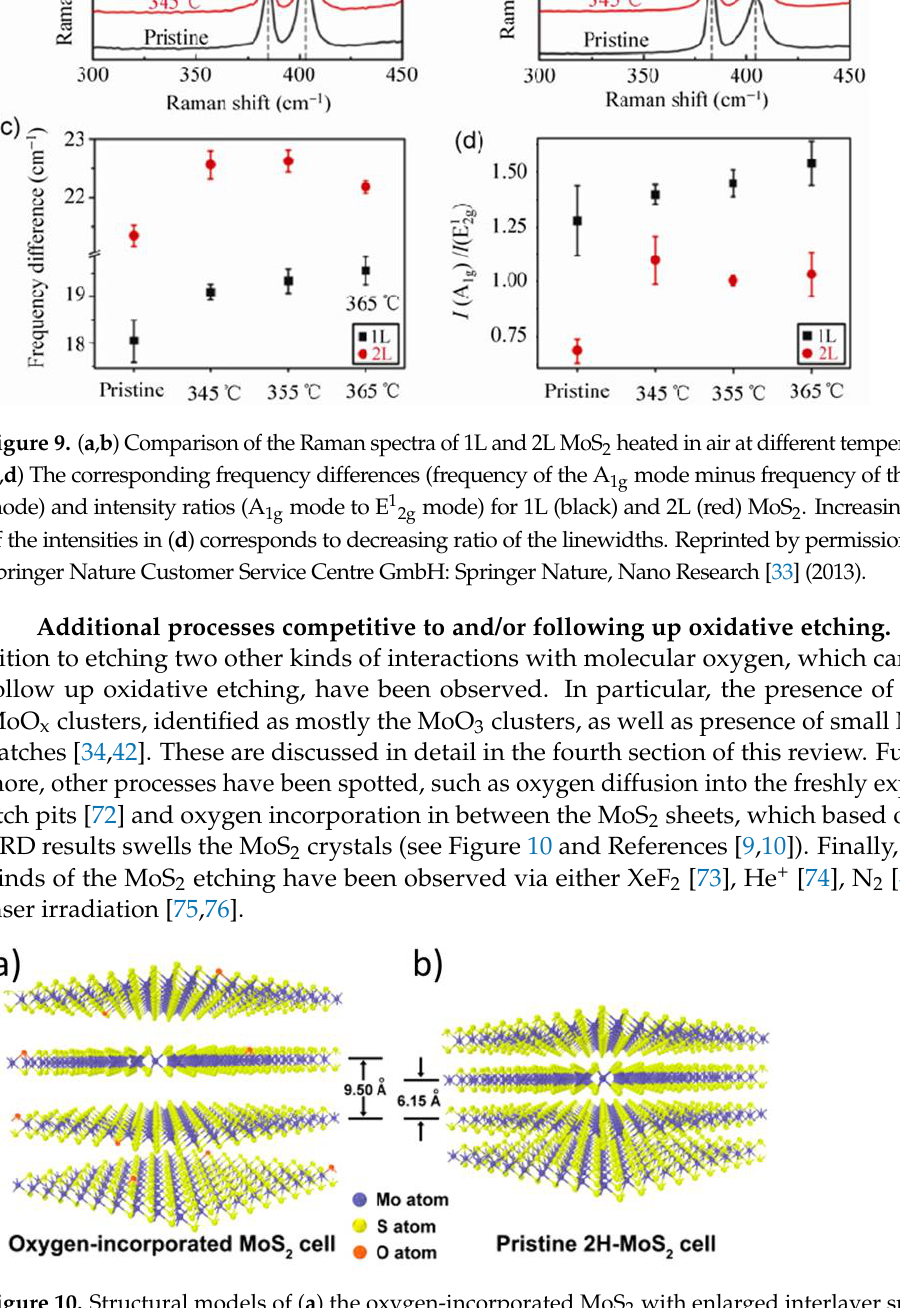
Figure 10. Structural models of ( a ) the oxygen-incorporated MoS 2 with enlarged interlayer spacing and ( b ) the pristine 2H-MoS 2 . Reprinted from Reference [10], with permission. Copyright 2013 American Chemical Society. American Chemical